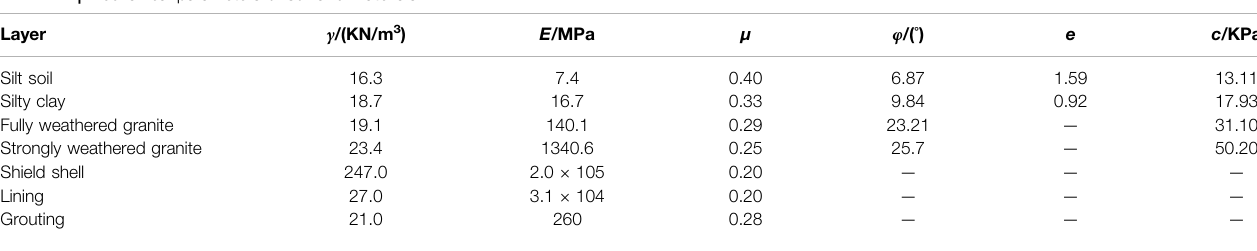
TABLE 1 | Mechanical parameters of soil and materials. Layer Silt